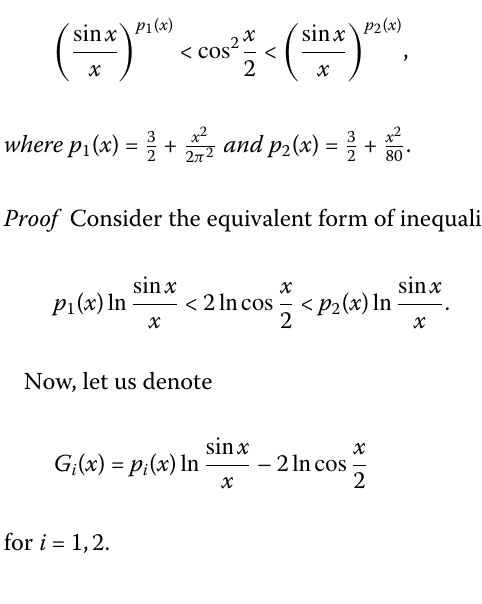
Table 1 Values x a and m a for some specified a ∈ ( 3